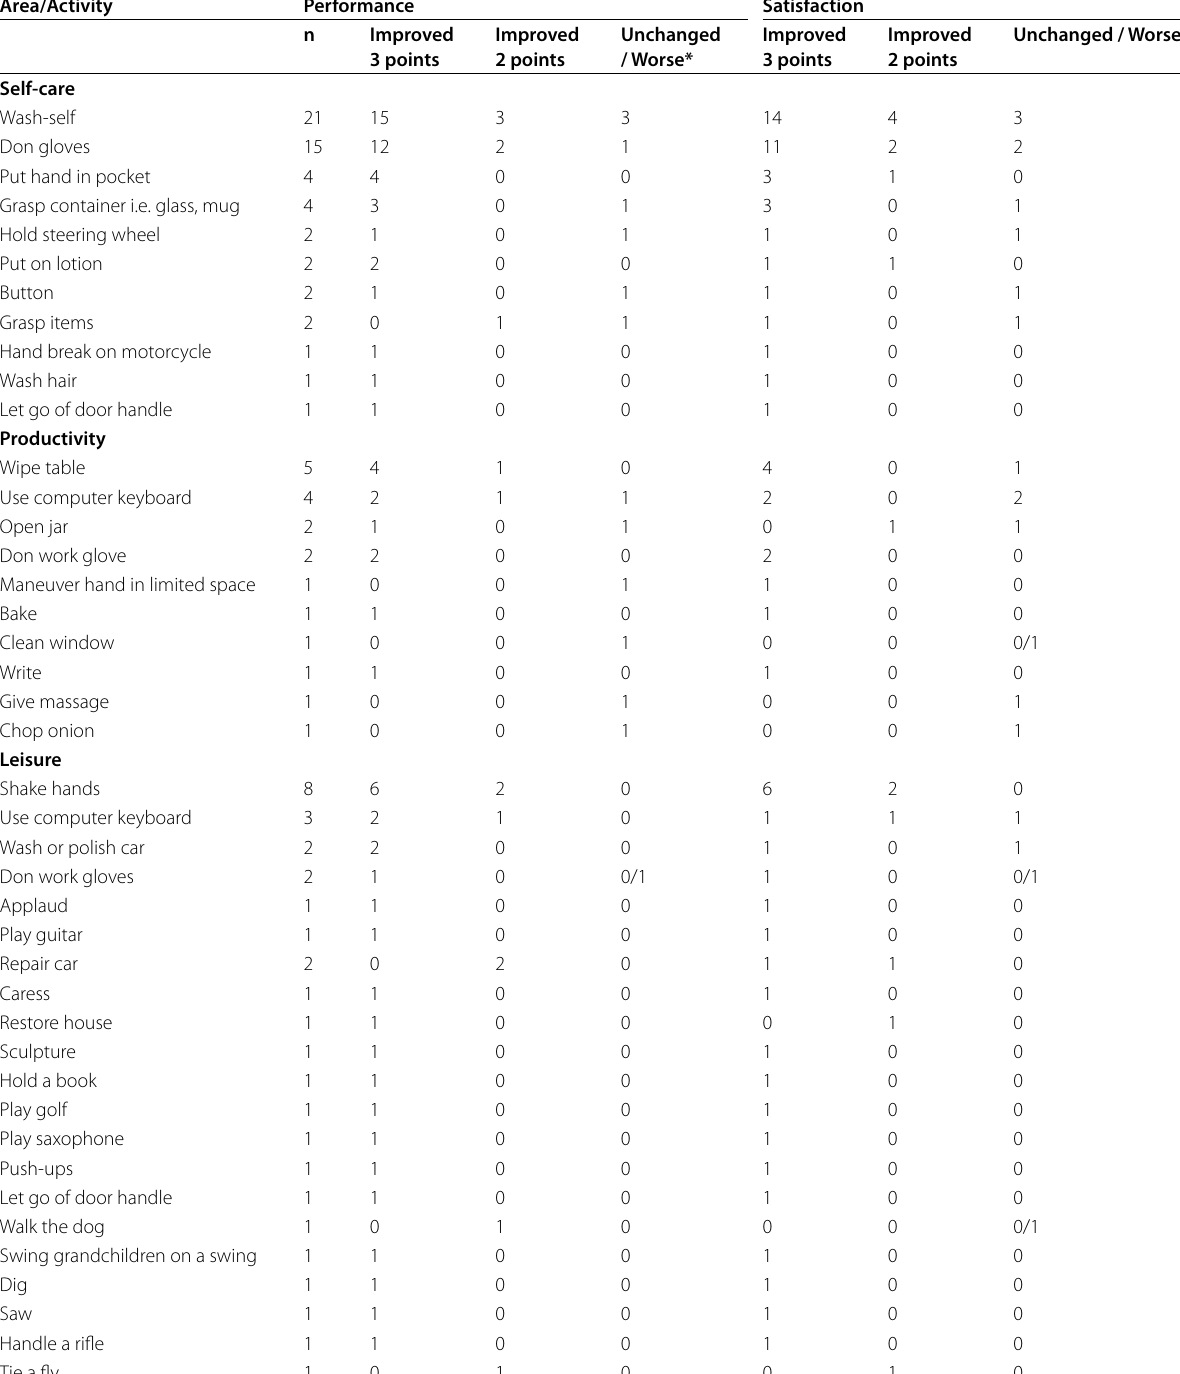
Table 2 All activities identified by the patients in each of the three areas of the Canadian Occupational Performance Measure